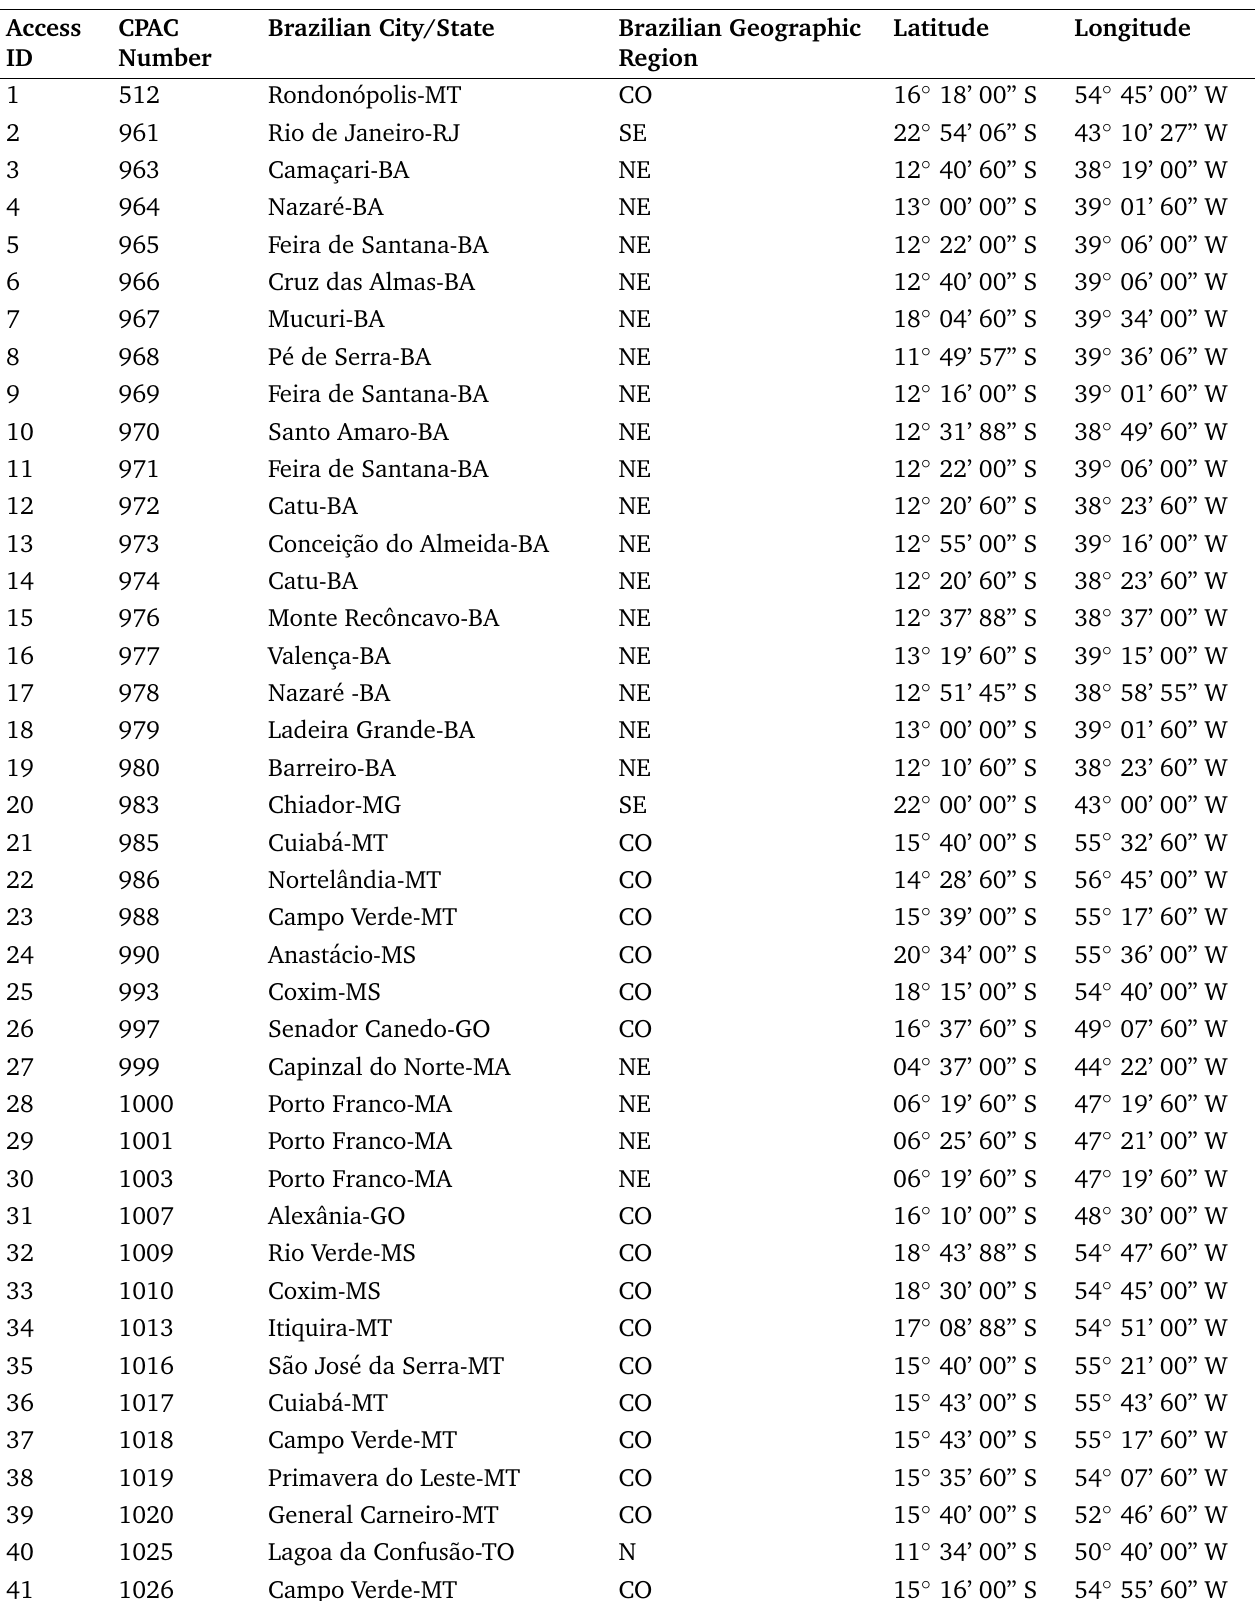
Table 1. Passport data of Stylosanthes scabra Vogel accessions from the Embrapa Cerrados germplasm bank. Embrapa Cerrados, Planaltina, DF, 2020. CPAC Number, Germplasm bank accession number. Brazilian States: BA, Bahia; GO, Goi´as; MA, Maranh˜ao; MG, Minas Gerais; MT, Mato Grosso; MTS, Mato Grosso do Sul; PA, Par´a; RJ, Rio de Janeiro; TO, Tocantins. Brazilian